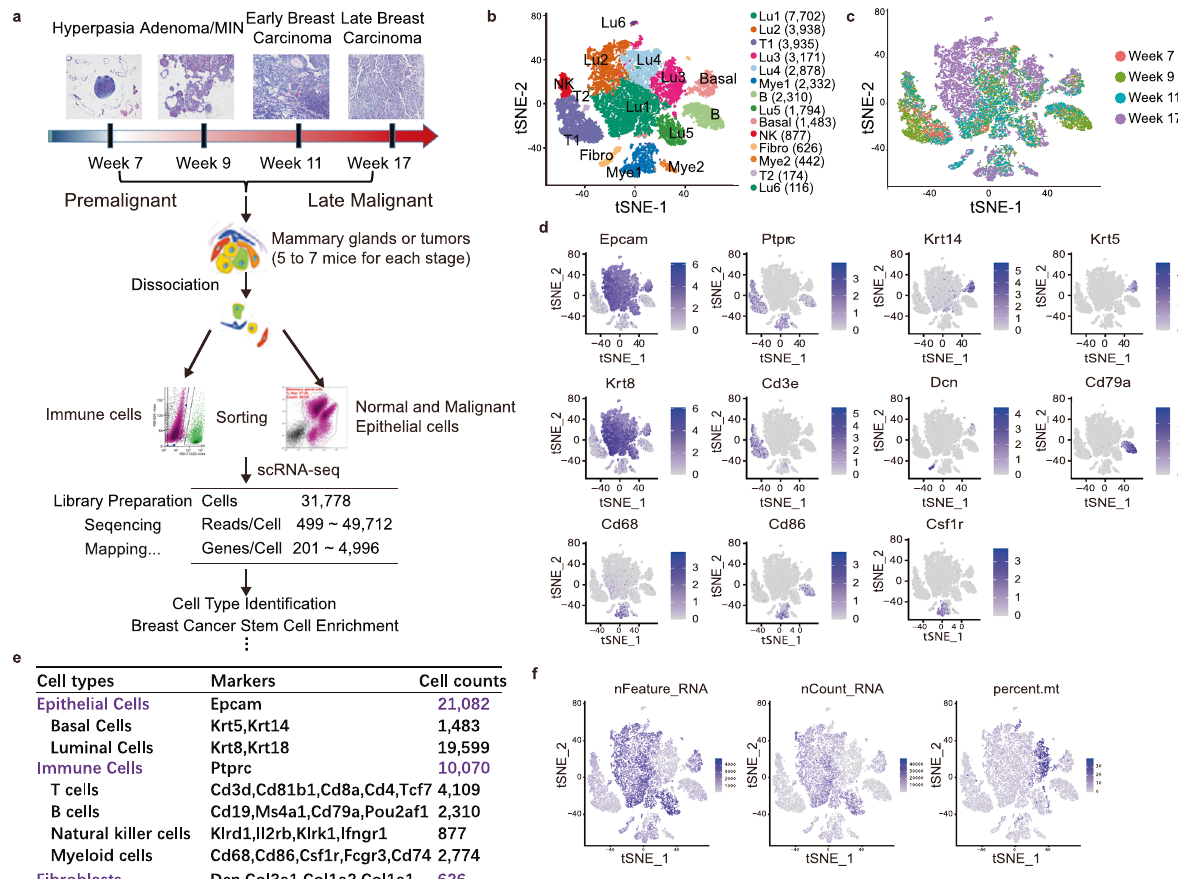
Fig. 1 Single-cell analysis of mammary glands and tumors from MMTV-PyMT mice. a A schematic diagram highlighting the work fl ow including isolation and sequencing of single cells for this study. Single cells were prepared from the 4th pair of mammary glands of MMTV- PyMT mice at different tumor progression stages including hyperplasia, adenoma/mammary intraepithelial neoplasia (MIN, early carcinoma) and malignant tumors (late carcinoma). The transcriptome of single cells was sequenced using the 10x Chromium system. b The t-SNE plot of 31,778 single cells to visualize cell-type clusters based on the expression of known markers, Lu1, 2, 3, 4, 5, and 6: luminal epithelial cell cluster 1, 2, 3, 4, 5, and 6; Basal: basal epithelial cell cluster; Fibro: fi broblast cluster; T1 and 2: T cell cluster 1 and 2; B: B cell cluster; NK: natural killer cell cluster; Mye1 and 2: myeloid cell cluster 1 and 2. c The t-SNE plot of single-cell transcriptomes from the isolated cells at indicated tumor progression stages including week 7, week 9, week 11, and week 17. d The individual gene t-SNE plots showing the expression levels